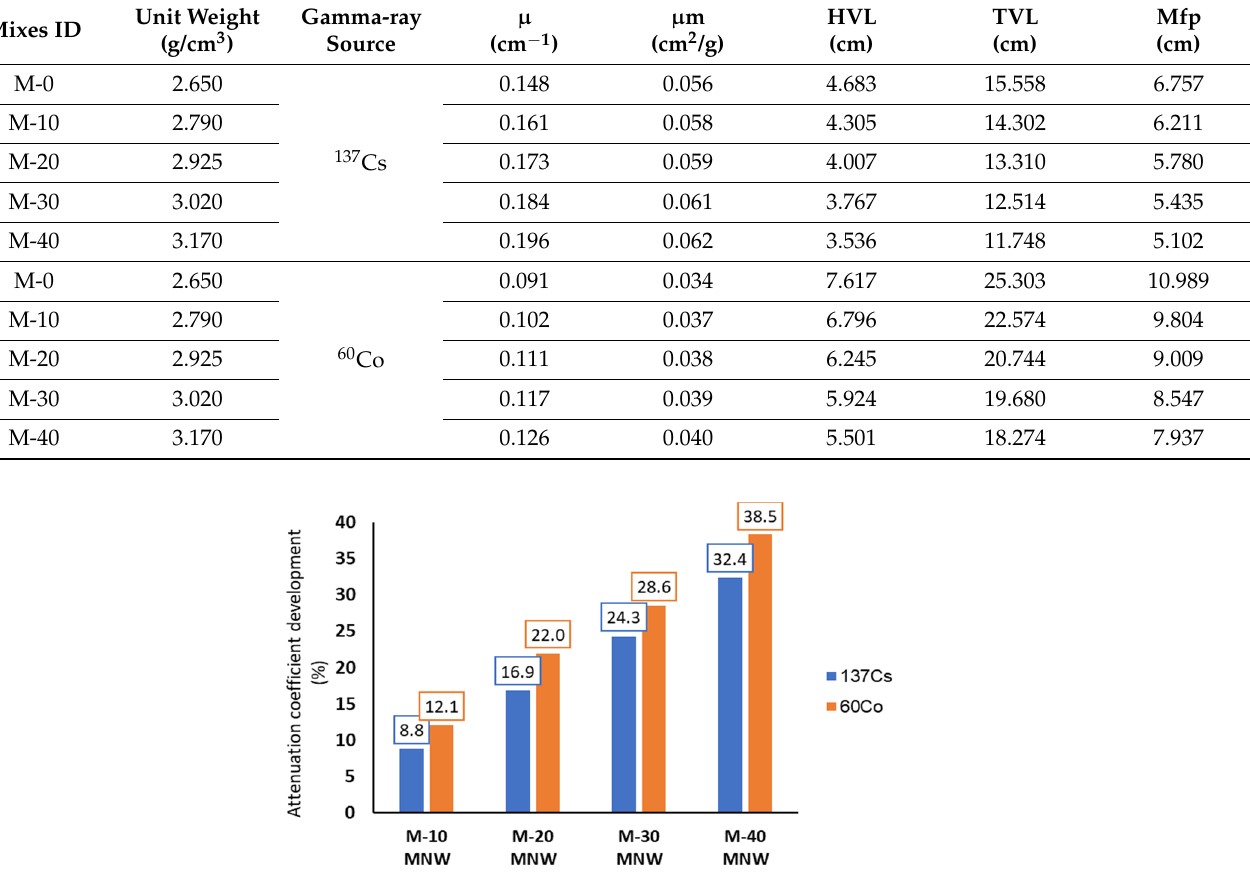
Figure 7. Attenuation coefficient ( µ ) development of sustainable HWC mixes.